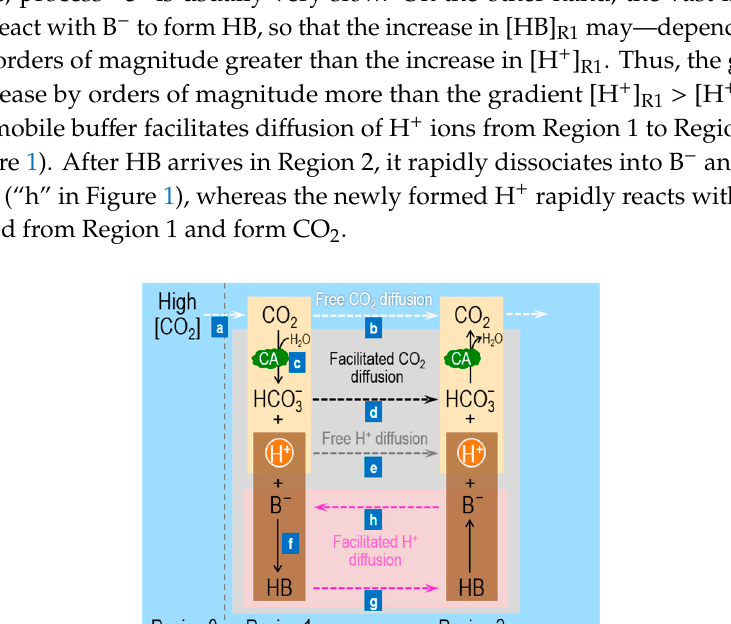
Figure 1. Schematic of the reaction and diffusion processes involved in facilitated CO 2 diffusion. Before time zero, we assume that Regions 0, 1, and 2 have identical compositions, with all reactions being in equilibrium and no concentration gradients existing between Regions. At time zero, we establish a CO 2 gradient from Region 0 (high [CO 2 ]) to Region 1 (low [CO 2 ]) in the presence of HB/B – , a generic non-CO 2 /HCO 3 − buffer. Although CO 2 is the only species moving from Region 0 to Region 1, all species can move between Region 1 and Region 2. Some CO 2 moves from Region 1 to Region 2 by free diffusion. The shaded grey area identifies facilitated CO 2 diffusion (i.e., HCO 3 − and H + moving in the same direction as CO 2 ) from Region 1 to Region 2. The pink shaded area identifies facilitated H + diffusion (i.e., the antiparallel movements of HB and B – , with HB [the weak acid] moving in the same direction as CO 2 [the potential weak acid]). The solid arrows identify reactions, and the dashed arrows identify free solute diffusion. These reaction and diffusion events greatly accelerate the transfer of carbon (in the guise of CO 2 or HCO 3 − ) from Region 1 to Region 2. For details, see text. CA, carbonic anhydrase.